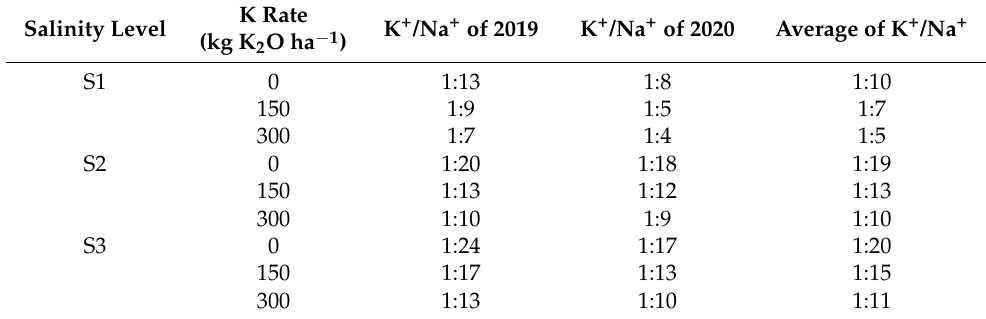
Table 2. The soil K + /Na + ratio after K